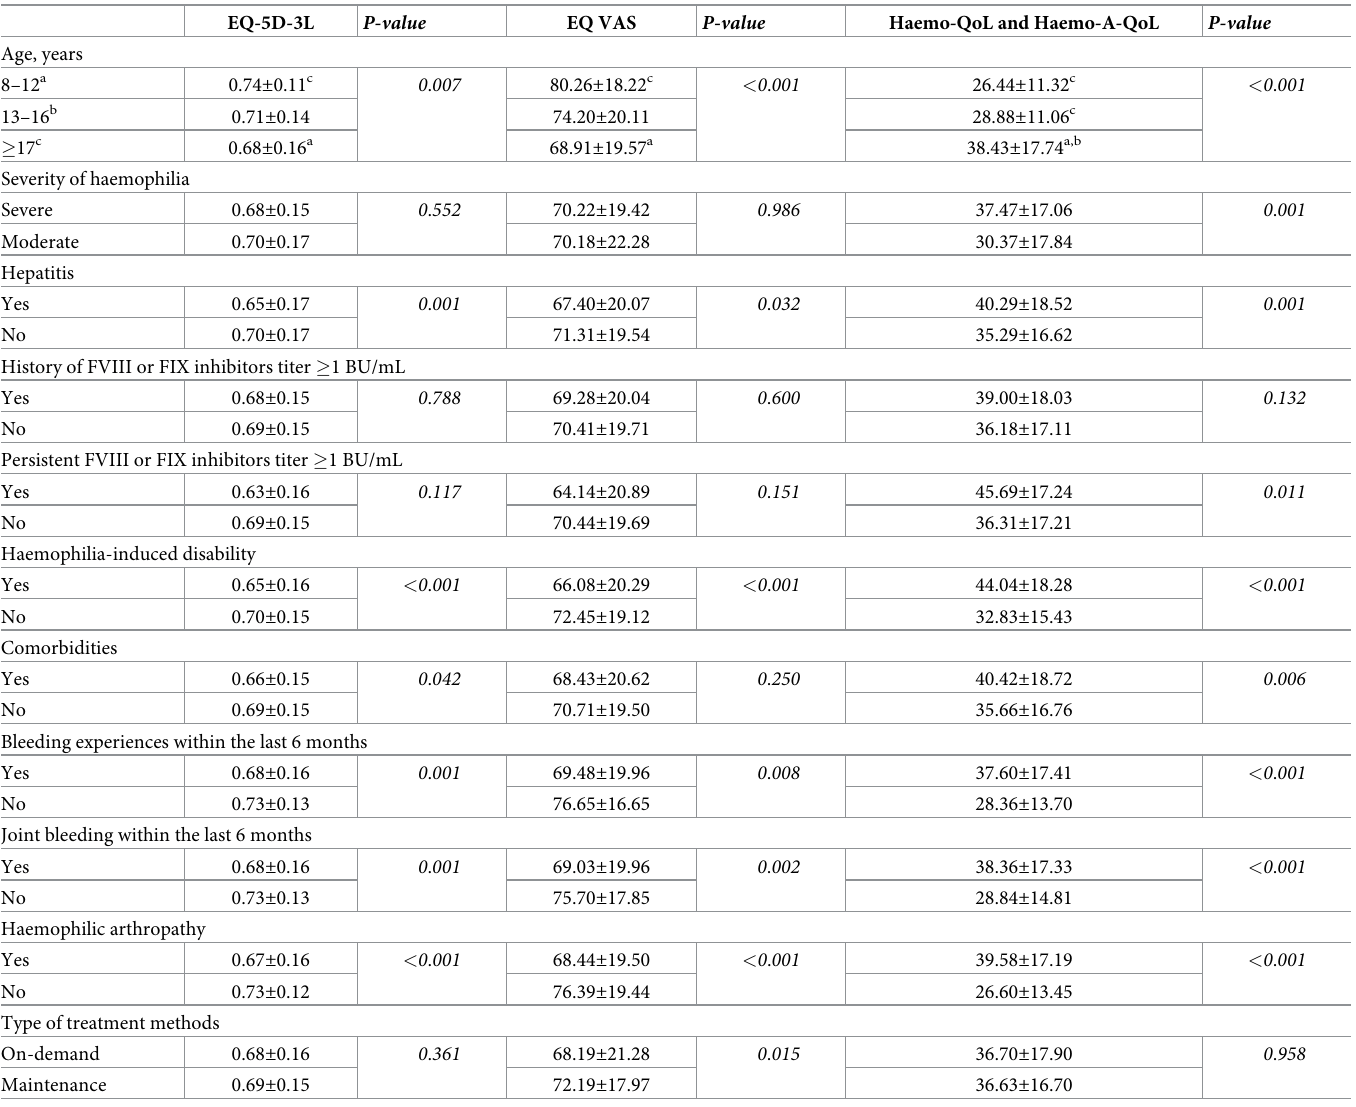
Table 2. Comparison of health-related quality of life according to patients’ characteristics.